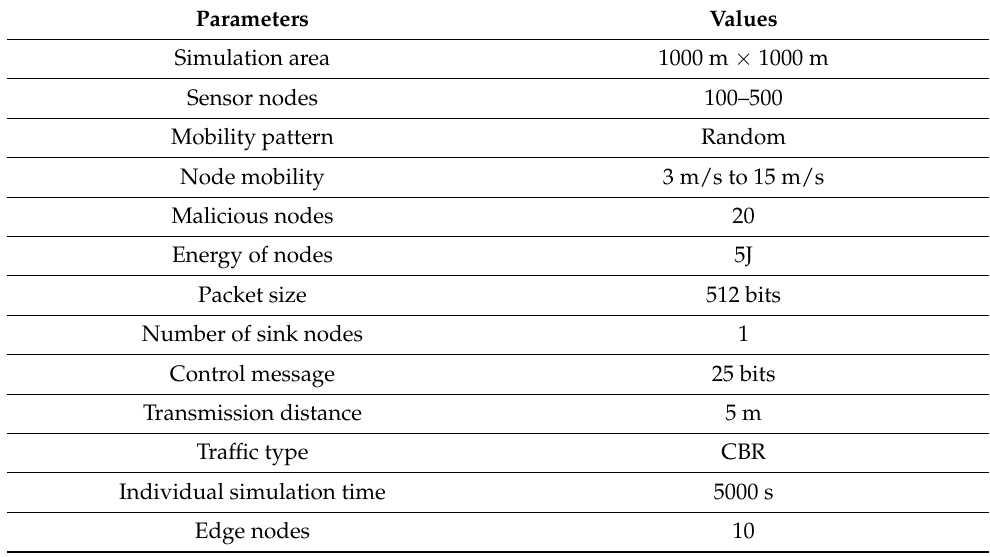
Table 3. List of simulation